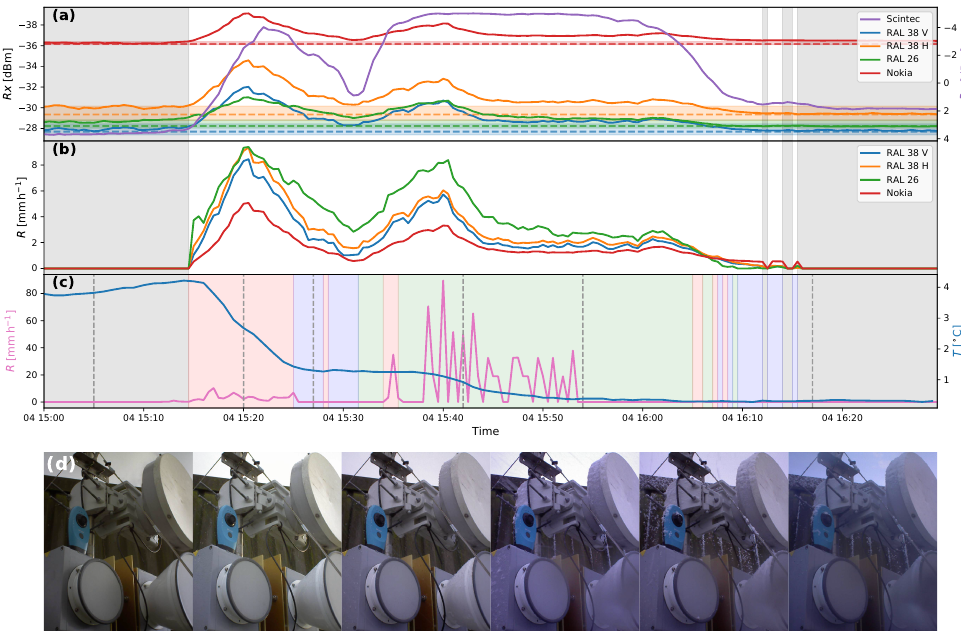
Figure 9. Time series of an event on 4 February 2015. (a) Received power levels at the detectors (solid lines) and reference levels (median over dry periods in a 24h moving window: dashed lines). The 5th and 95th percentile power levels over dry periods in a 24h moving window are indicated by the coloured shading. (b) Derived rainfall intensities using the basic algorithm. (c) Rainfall intensities derived from the disdrometer positioned at “Forum” and ambient air temperature at 2m at the “Veenkampen” meteorological station. Dry periods, as determined with the disdrometers, are represented by grey shaded areas. Periods with mixed precipitation are indicated with red shaded areas; periods where only liquid precipitation is detected are indicated in blue; and periods with snow are indicated in green. (d) Images from the time-lapse camera at the location of the transmitting antennas aimed at the antennas. The times at which these images were capture are indicated by the vertical dashed lines in (c)